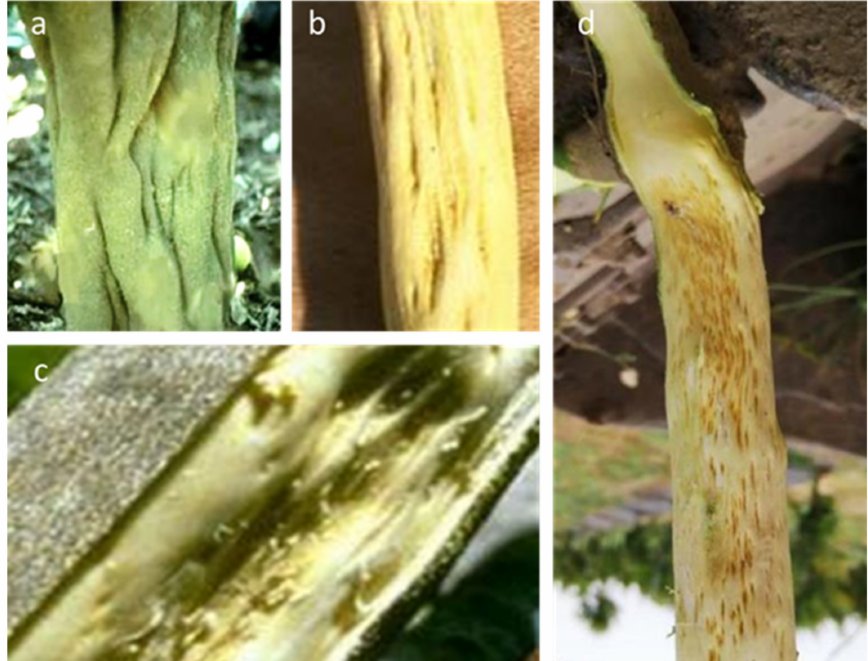
Figure 3. Symptoms of tristeza stem pitting caused by SP isolates of CTV on the trunk ( a ), stem ( b ) and branch ( c ) of grapefruit. Similar effects may occur on some sweet orange varieties and on indicator plants, or on alemow used as rootstock ( d